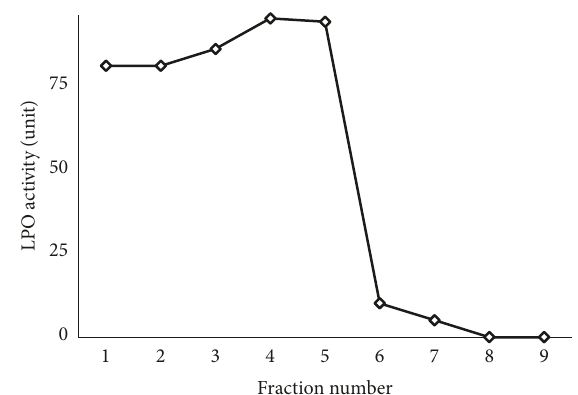
Figure 1: LPO activity in nine fractions obtained from the elution of 0.4 mM NaCl in 0.1 mM phosphate buffer of pH 7.0 through column containing Sepharose (cid:2) Big Beads.